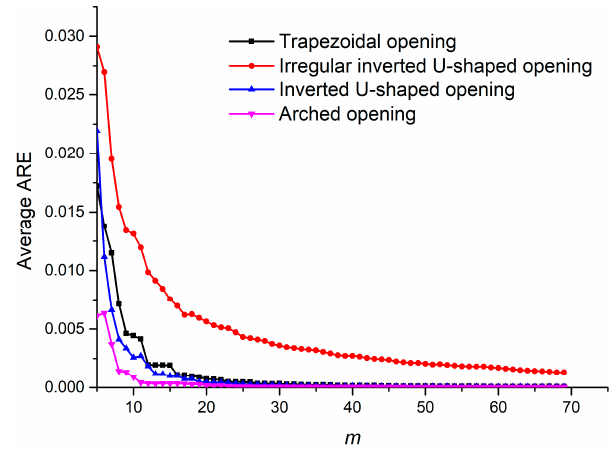
Figure 5. The relation curves between average ARE and m.